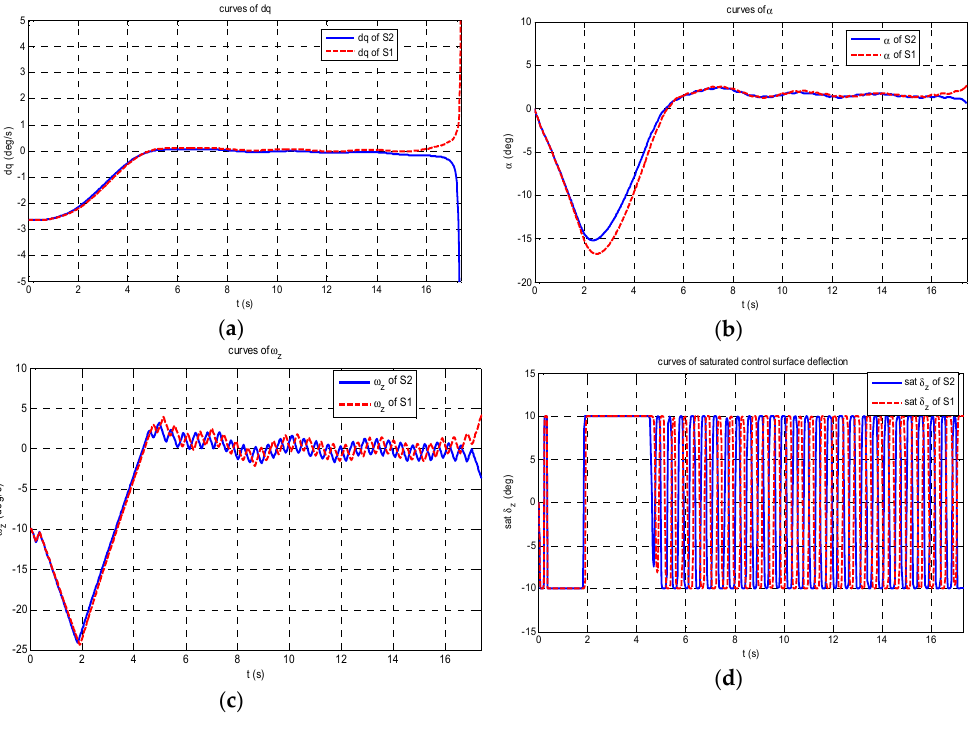
Figure 3. Comparison between S1 and S2: ( a ) curves of q , ( b ) curves of